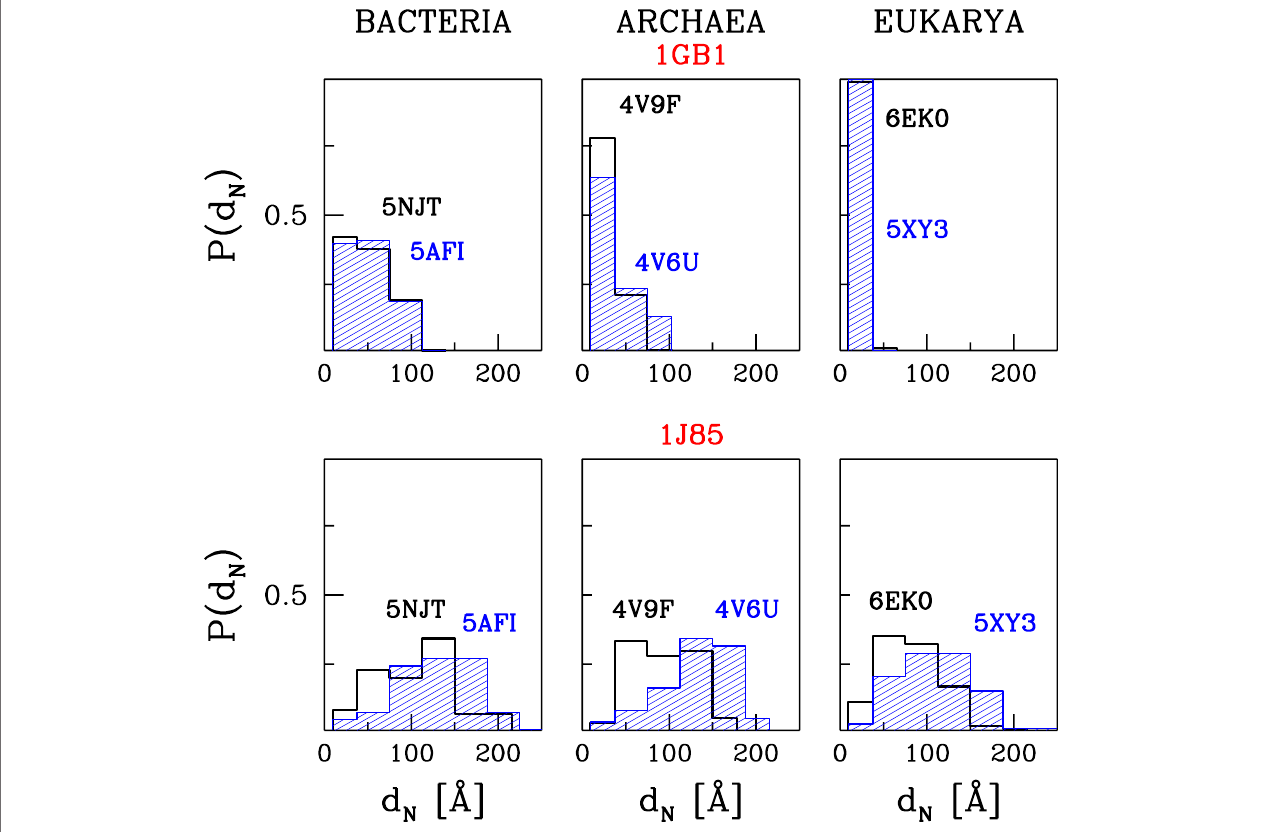
FIGURE 5 | The histograms of the distances between PTC and the N-terminus after time t E of simulations at T R (cid:1) 0.35 ε / k B and with t w (cid:1) 100 τ . The results are for three different domains of life. The upper panels are for 1GB1, with t E (cid:1) 50000 τ , and the lower ones for 1J85, with t E (cid:1) 150000 τ